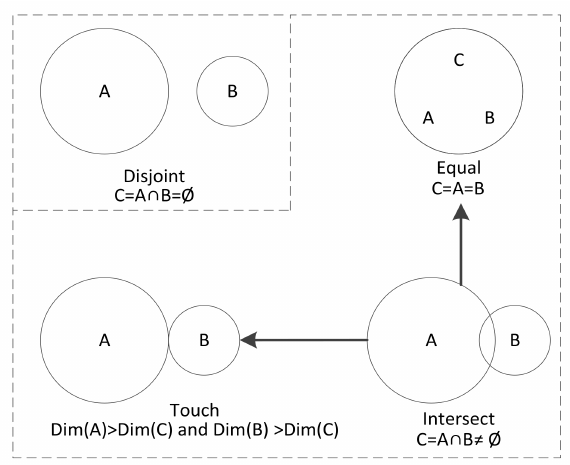
Figure 5. Classes of topological relations in cadastral spaces.